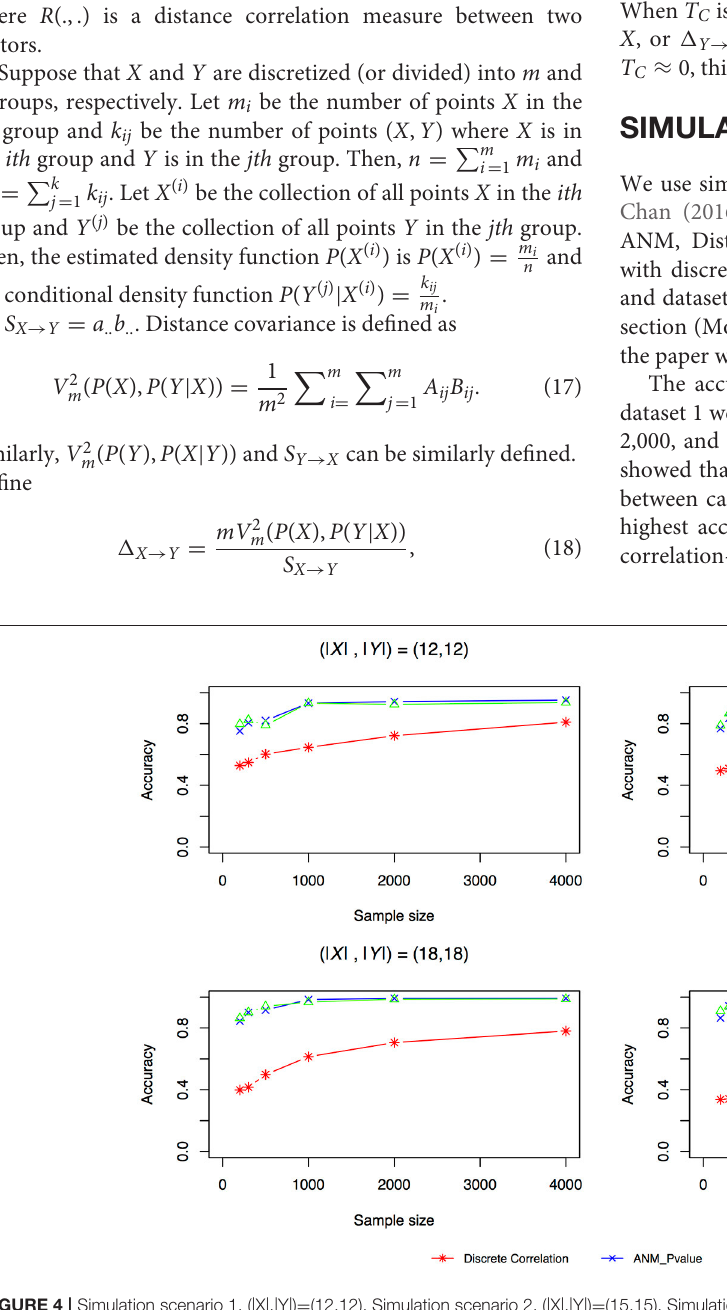
Frontiers in Genetics |